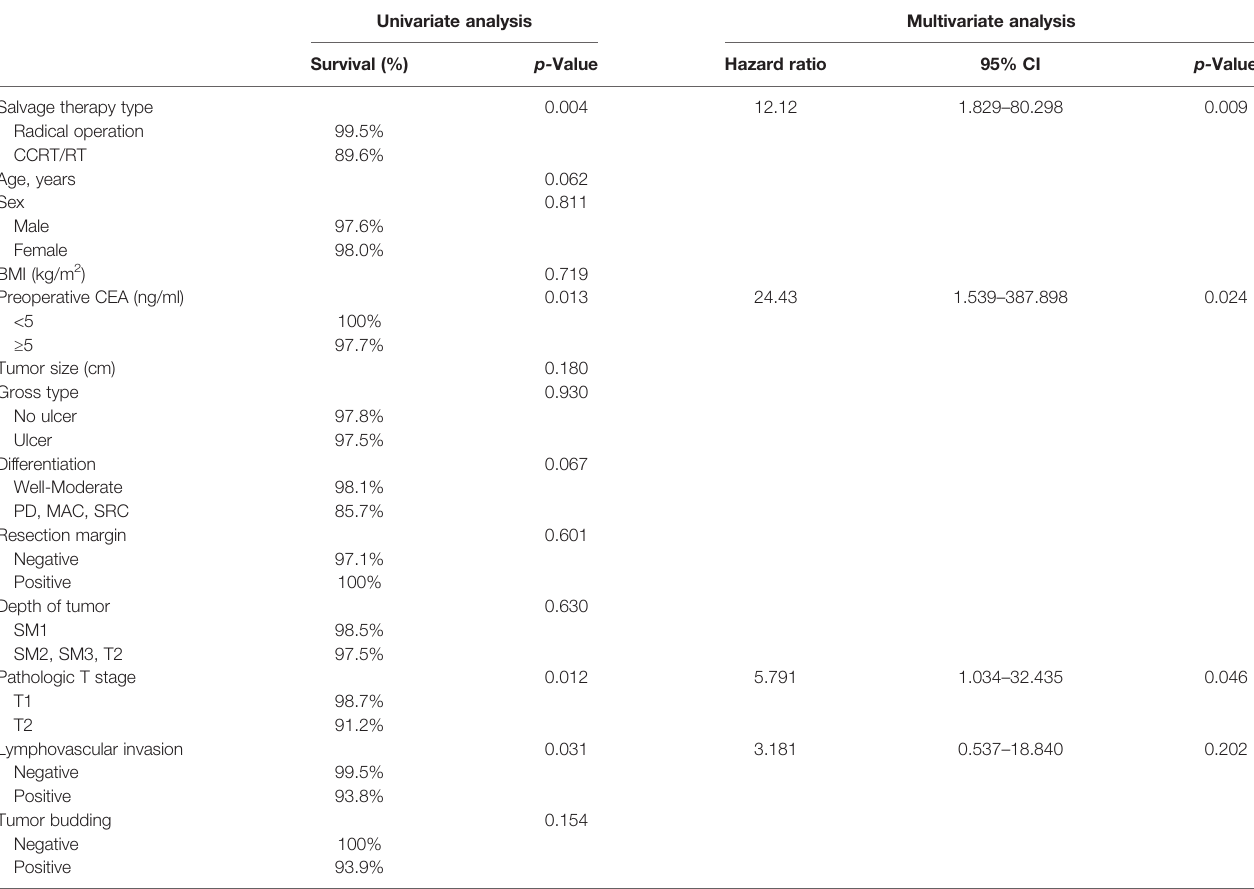
TABLE 4 | Univariate and multivariate analyses of prognostic factors for 5-year overall